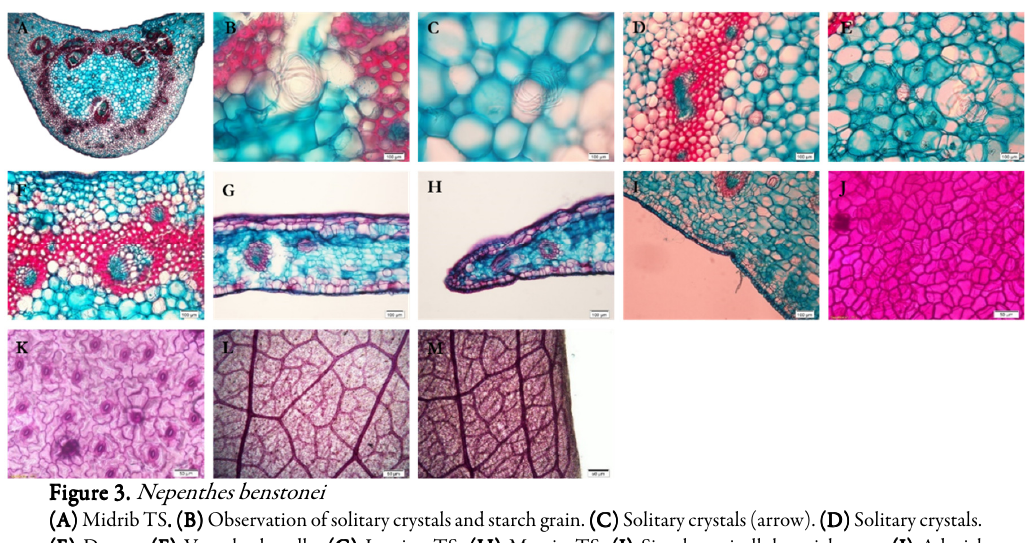
Figure 3. Nepenthes benstonei (A) Midrib TS. (B) Observation of solitary crystals and starch grain. (C) Solitary crystals (arrow). (D) Solitary crystals. (E) Druses. (F) Vascular bundle. (G) Lamina TS. (H) Margin TS. (I) Simple, unicellular trichomes. (J)